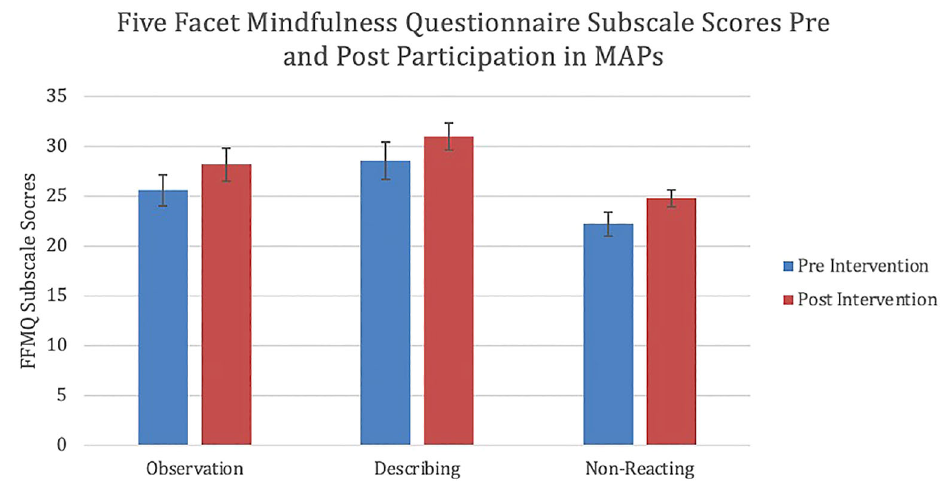
Figure 2. Mean change in observation (p = 0.036), describing (p = 0.042) and non-reacting (p = 0.019) FFMQ subscale scores following participation in MAPs. Error bars represent standard errors (SEM). FFMQ: Five Facet Mindfulness Questionnaire. MAPs: Mindfulness Awareness Practices.